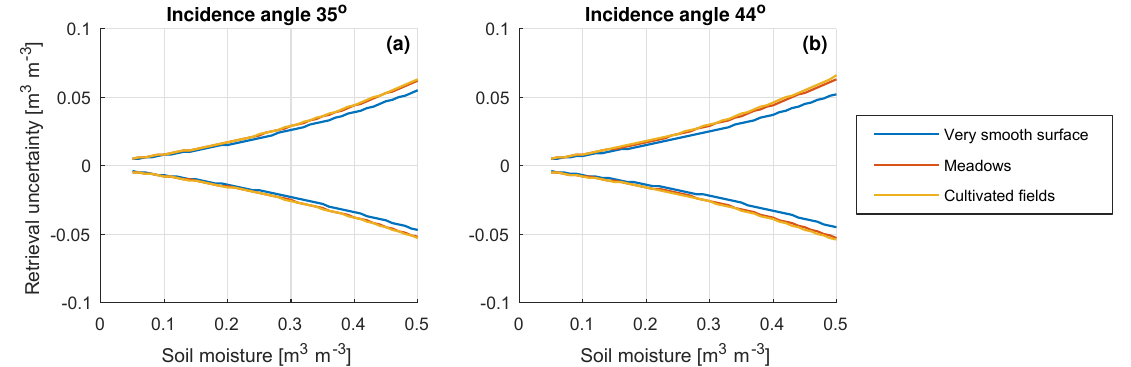
Figure 13. Upper ( ∆ θ + ) and lower boundary ( ∆ θ − ) of the soil moisture retrieval uncertainty due to the s S 1 at VV polarization at 1km resolution as a function of soil moisture, for incidence angles of 35 ◦ ( a ) and 44 ◦ ( b ) and for the three surface roughness scenarios (Table